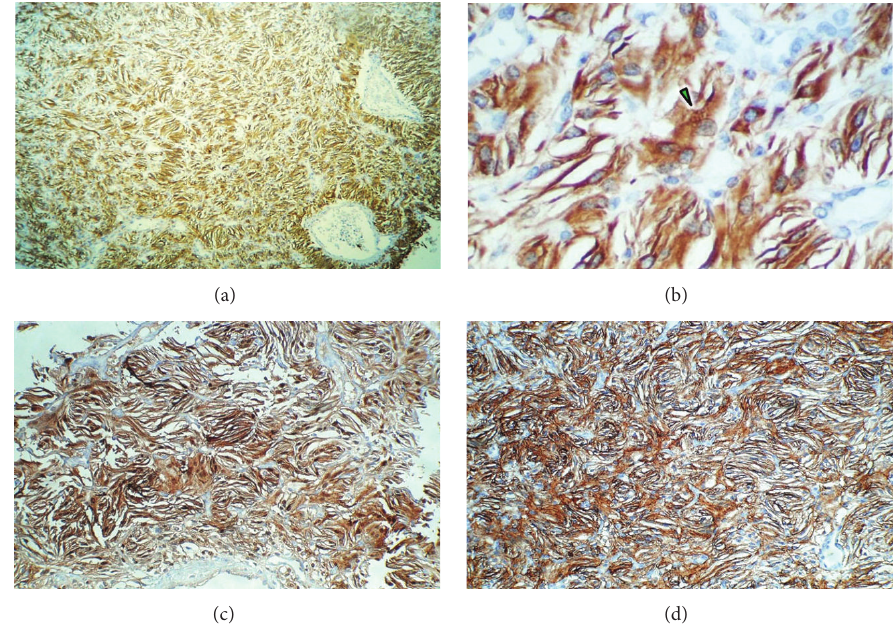
Figure 3: Immunohistochemistry panel. (a) Inhibin A. Ubiquitous expression of this marker in the spindle cell component. (b) Inhibin A. A small hint of lipidization can be identified in one of the giant cells (green arrow). (c) PS100. Confirmative immunostaining of spindle cells. (d) CD57. Corroborative immunolabeling of fusiform cells.